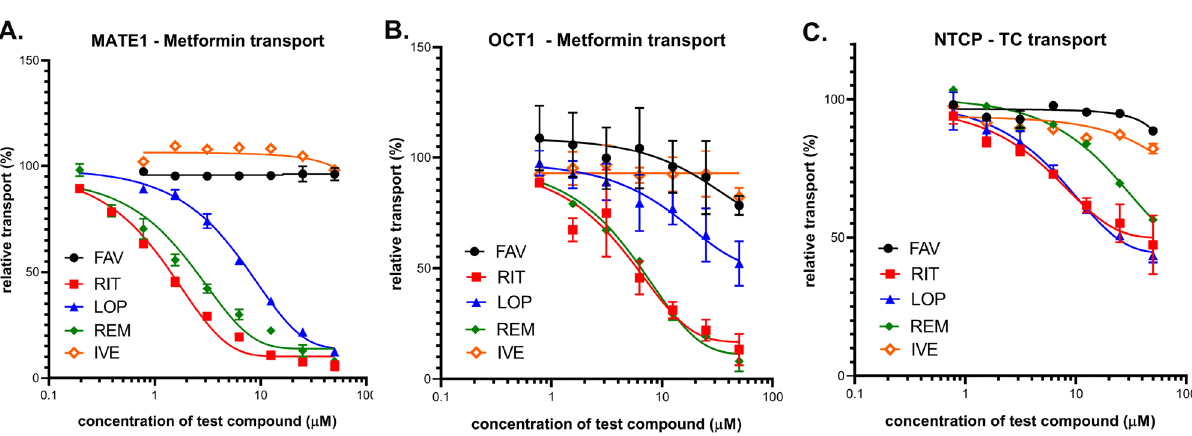
Figure 4. Inhibition of the cellular uptake of transporter-specific substrates by the repurposed anti-COVID agents FAV, RIT, LOP, REM and IVE. ( A ) Inhibition of MATE1 dependent metformin uptake in MATE1- overexpressing MDCKII cells. Uptake was measured by 10 µM metformin for 10 min at 37 °C. Average values of 3 independent experiments +/− SE are shown. ( B ) Inhibition of OCT1-dependent metformin uptake in OCT1-overexpressing HEK cells. Uptake was measured by 10 µM metformin for 5 min at 37 °C. Average values of 3 independent experiments +/− SE are shown. ( C ) Inhibition of NTCP-dependent taurocholate uptake in NTCP-overexpressing HEK cells. Uptake was measured by 2 µM taurocholate for 2 min at 37 °C. Average values of 3 independent experiments +/− SE are